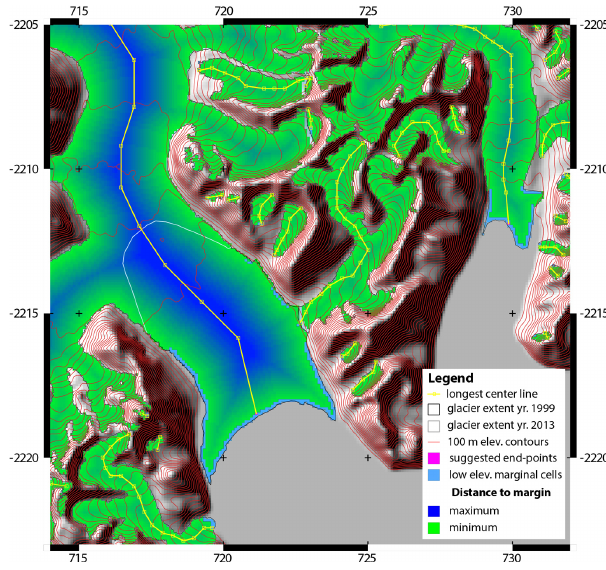
Figure 4. Concept of “suggested end points” demonstrated on the example of two tide-water glacier of the Geikie Plateau. Coordi- nates as in Fig.